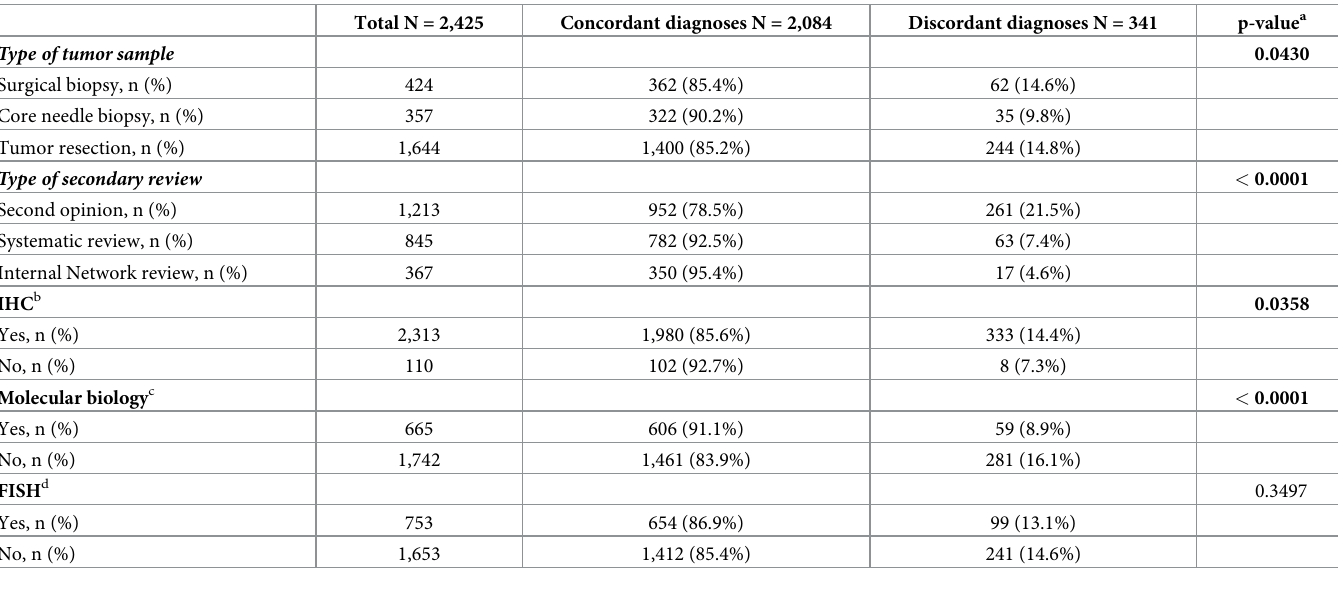
Table 2. Tumor sample